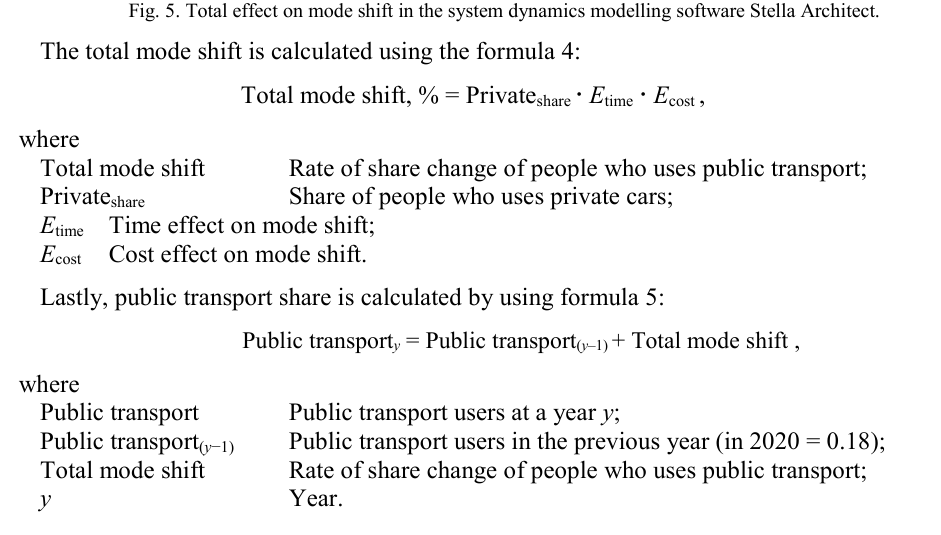
Fig. 5. Total effect on mode shift in the system dynamics modelling software Stella